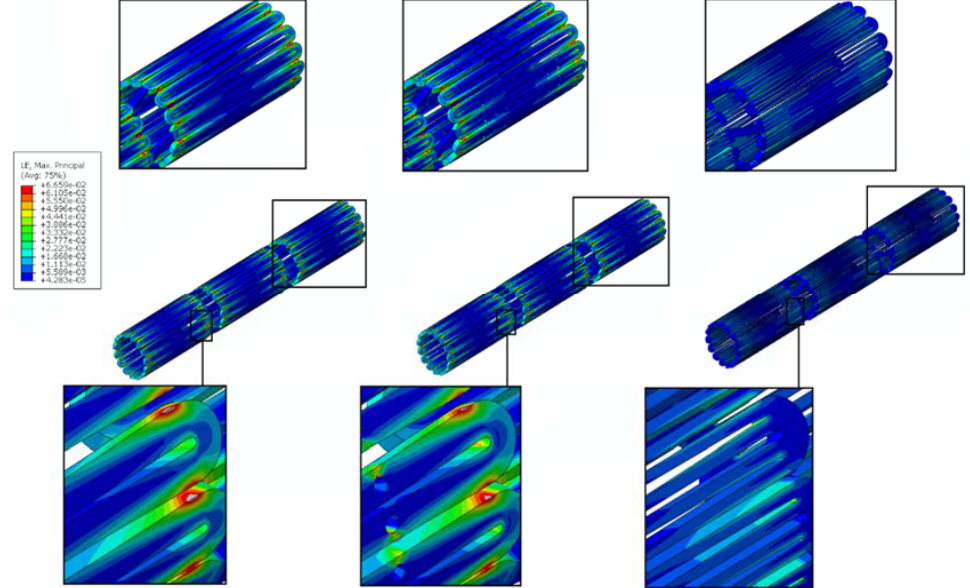
Figure 6. FEA contour plot comparison of strain distribution at 2.0 mm after crimping into a catheter among the conventional drug-eluting stent (DES) ( left ), conventional depot stent ( middle ), and rhombic-shaped channel stent ( right ).